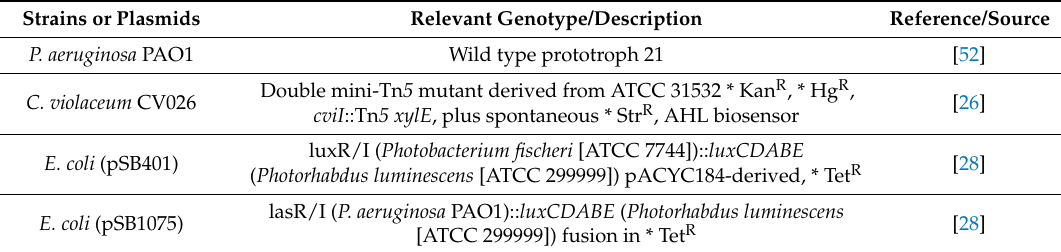
Table 1. Bacterial strains and plasmids used in this